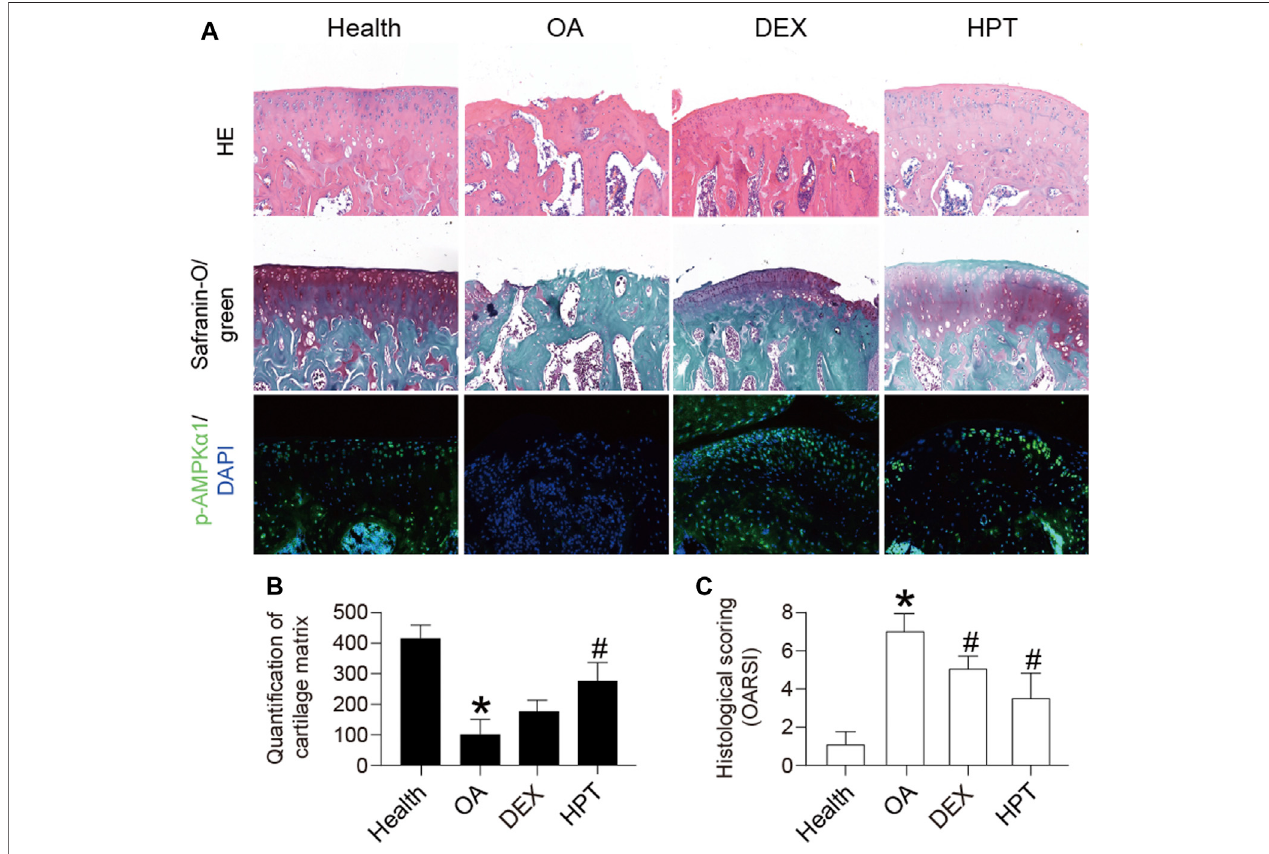
FIGURE 6 | Histological analysis of knee cartilage after HPT treatment (H&E, safranin-O/green, and IF), magni fi ed 100 times. For statistical analysis, * p < 0.05 was considered statistically signi fi cant compared with healthy; # p < 0.05 was considered statistically signi fi cant with OA. DEX, dexamethasone as positive control.